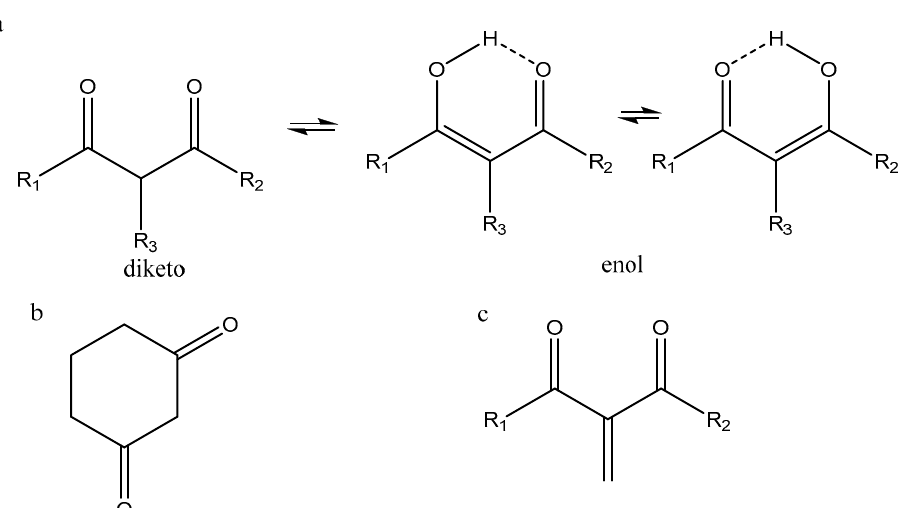
Figure 1. Classification of β -diketones. ( a ) lbdk type of β -diketones, ( b ) cbdk type, and ( c ) dbdk type.